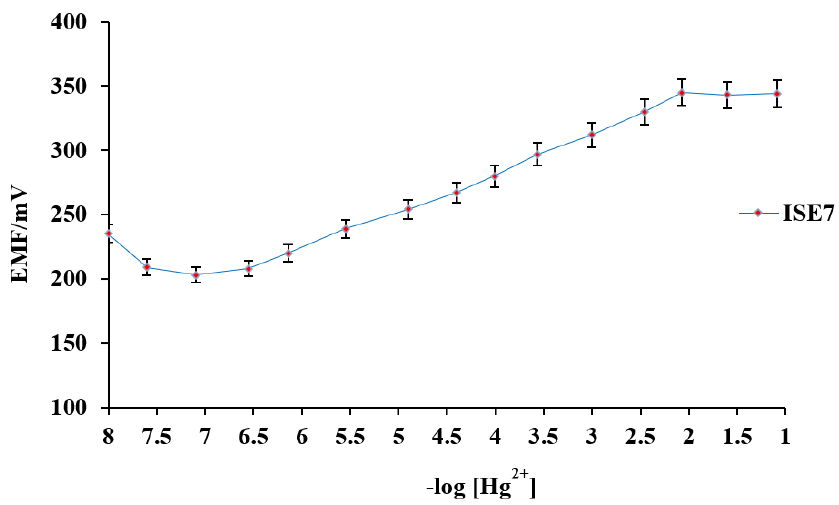
Figure 2. Calibration curve of the Hg 2+ -SE (ISE7) based on the BMPMP as ionophore . 3.2. ATR–FTIR Investigation of Hg 2+ –SE Membrane Based on BMPMP as an Ionophore ATR–FTIR spectra of Hg 2+ –SE membrane containing optimized composition were recorded before and after using for sensing Hg 2+ ions to obtain information on the ion– ligand interaction and specify the active sites available in BMPMP molecule that can coordinate with Hg 2+ ion. A thin layer of membrane was used to record ATR–FTIR spectra shown in Figure 3. ATR–FTIR spectrum of PVC membrane that does not contain BMPMP was recorded and subtracted from the spectra shown in Figure 3A,B. Characteristics bands of PVC membrane before soaking with analyte solution (Figure 3A) are observed at 3400, 1642, 1523, and 1407 cm − 1 corresponding to ν (O–H), ν (C = N), ν (C = C), and δ (O-CCH 3 ), respectively. Significant changes in the spectrum of membrane loaded with Hg(II) indicate an interaction between BMPMP and Hg 2+ ions in a PVC membrane matrix (Figure 3B). The disappearance of peak at 3400 cm − 1 corresponding to ν (OH) and the appearance of a new peak of ν (Hg–O) at 549 cm − 1 reveal that BMPMP ligand has coordinated with Hg 2+ ions by the phenolic OH. Coordination of Hg 2+ ions through nitrogen atom of BMPMP molecule is confirmed by the red shift of the ν (C = N) band from 1642 to 1600 cm − 1 and the appearance of new peak at 510 cm − 1 corresponding to ν (Hg–N)